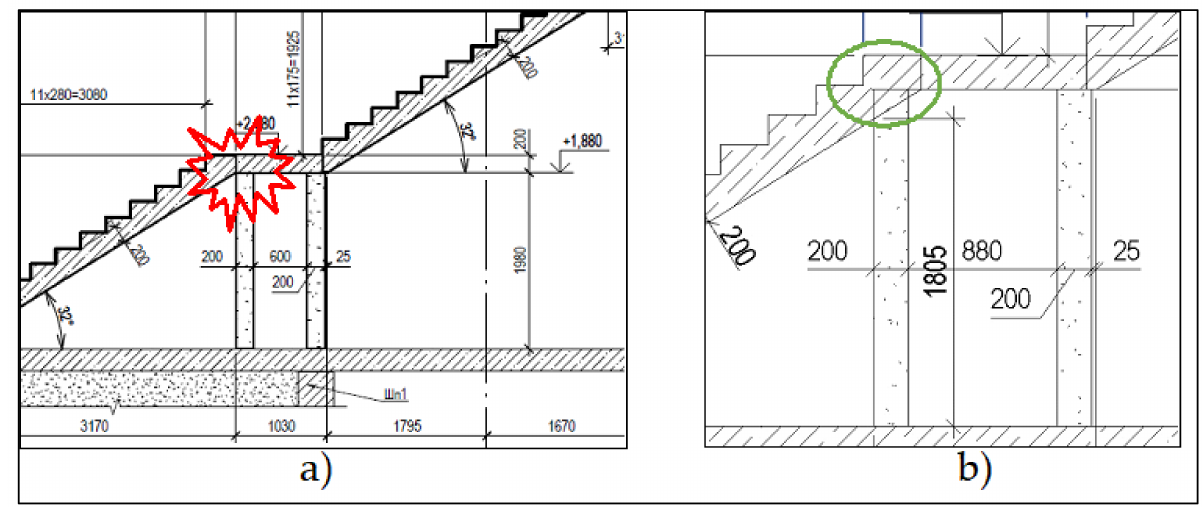
Figure 2. Example of a stair and column placement error ( a ) and the correct solution of a stair and column placement ( b ) (by the authors).